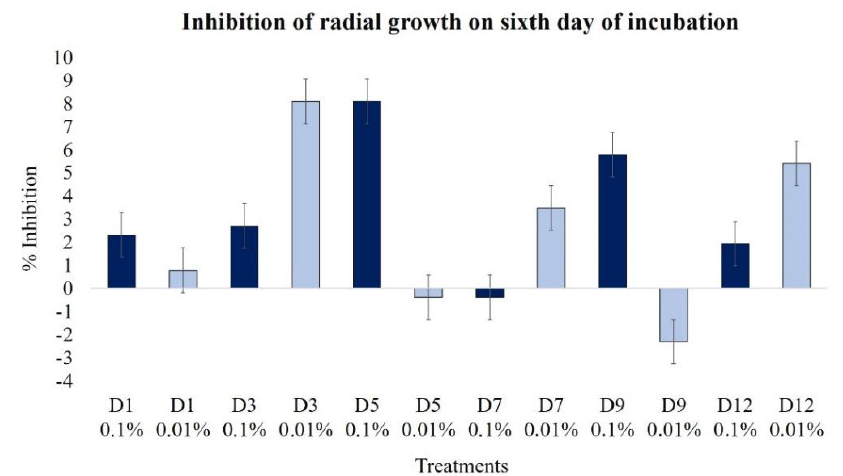
Figure 2. Effects of extracts at 0.1% (dark blue bars) and 0.01% (light blue bars) in the radial growth of B. cinerea on the sixth day. Extracts were applied 24 hours after conidia inoculation (concentration of 1 × 10 5 conidia mL –1 ).